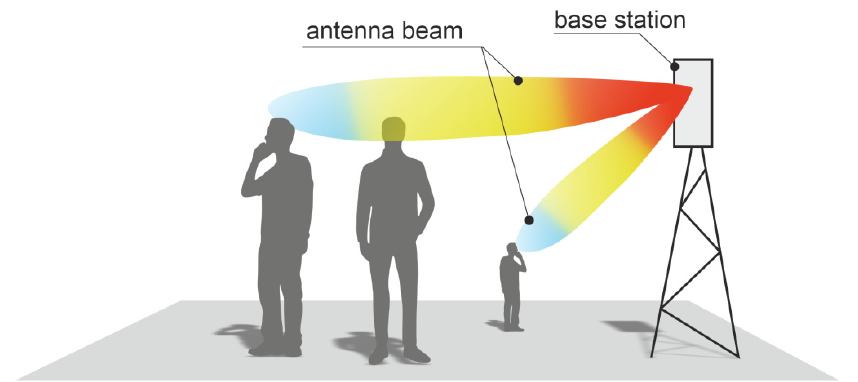
Figure 1. Problem scenario: exposure to 5G base station with multiple beams.